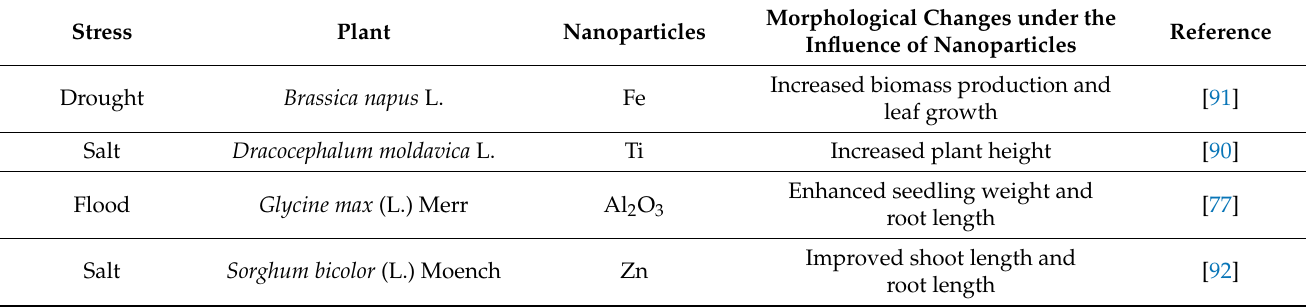
Table 1. Morphological changes under the influence of